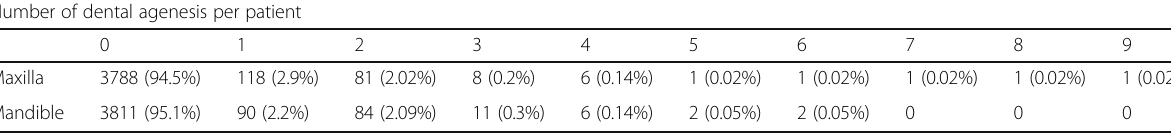
Table 3 Number of dental agenesis divided by dental arches Number of dental agenesis per patient